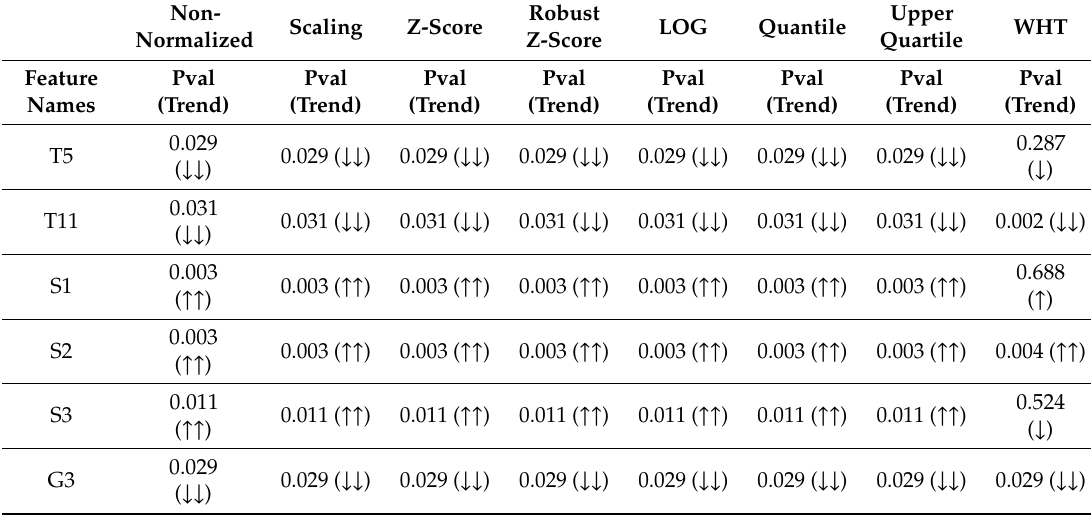
Table 3. Results from the Wilcoxon signed-rank test indicating association between MRI phenotype and molecular classification ER + versus